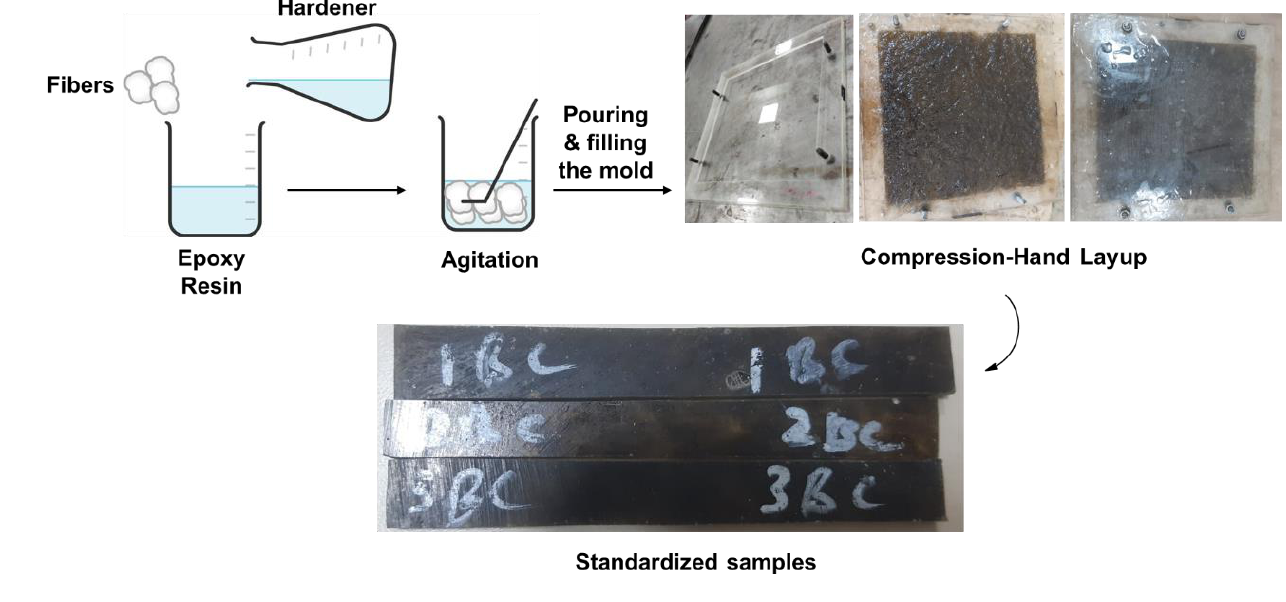
Figure 1. The fabrication process of the composites. All composites were coded according to Table 2, mentioned below. Table 2. Abbreviations of the composite samples. Sr.